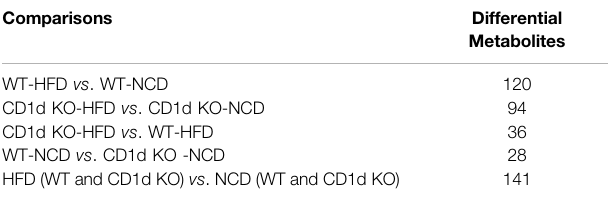
TABLE 1 | Differential metabolites in all comparison ’ s groups. Comparisons